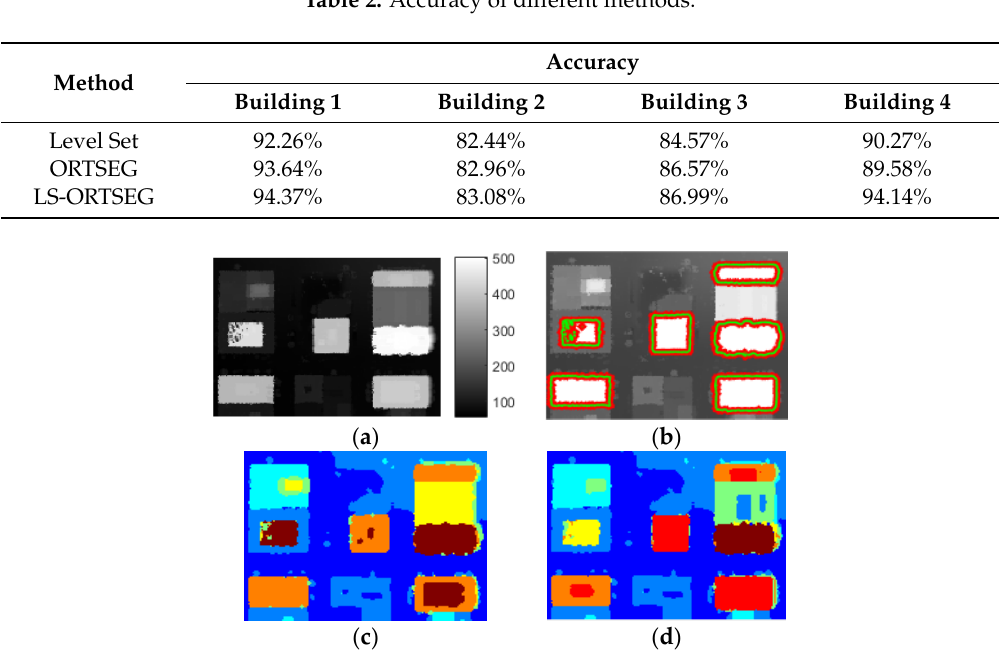
Figure 14. Original DSM and segmentation results of Dataset 2. ( a ) DSM ( b ) Level-set; ( c ) ORTSEG; ( d ) LS-ORTSEG. ‘Hist.wSize’ = 3, ‘NumTextures’ = 7 for both ORTSEG and LS-ORTSEG.